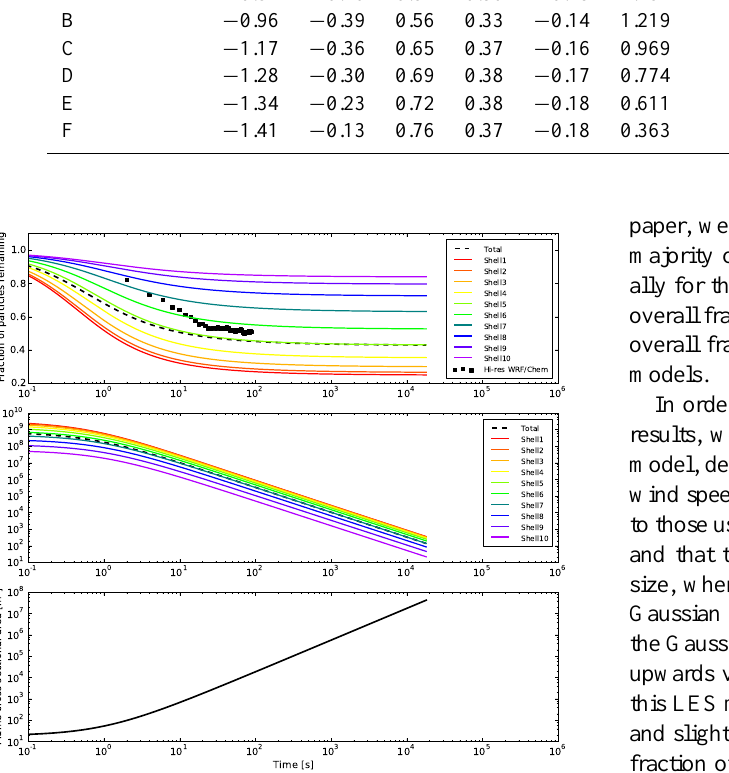
Fig. 3. The fraction of particles remaining, the concentrations, and the plume cross-sectional area are shown over time for each shell for the base case. The black dashed line shows the average across the plume, and the black square points show high-resolution results from the WRF/Chem large-eddy simulation